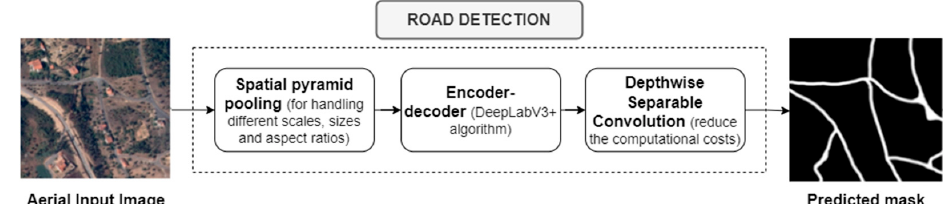
Figure 5. Road region detection module of the rural road centerline extraction method. A Python image segmentation neural network framework based on PyTorch was used to implement the proposed DeepLabV3+ model. The model parameters used to build the proposed road detection architecture are as